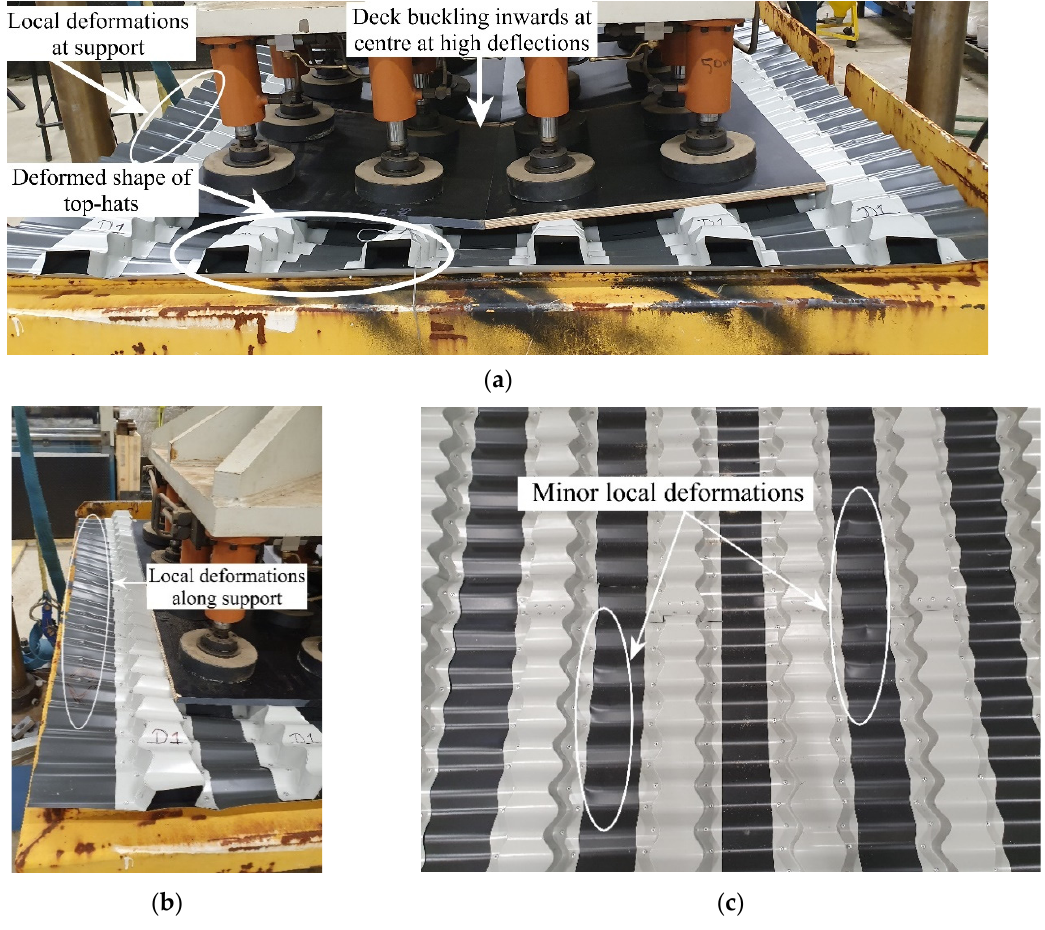
Figure 3. Failure modes of two-way deck system. ( a ) Failed deck with deformed top-hats. ( b ) Local deformations seen on a corrugated base sheet at supported points. ( c ) Minor local deformations on the corrugated base sheet at ultimate load .